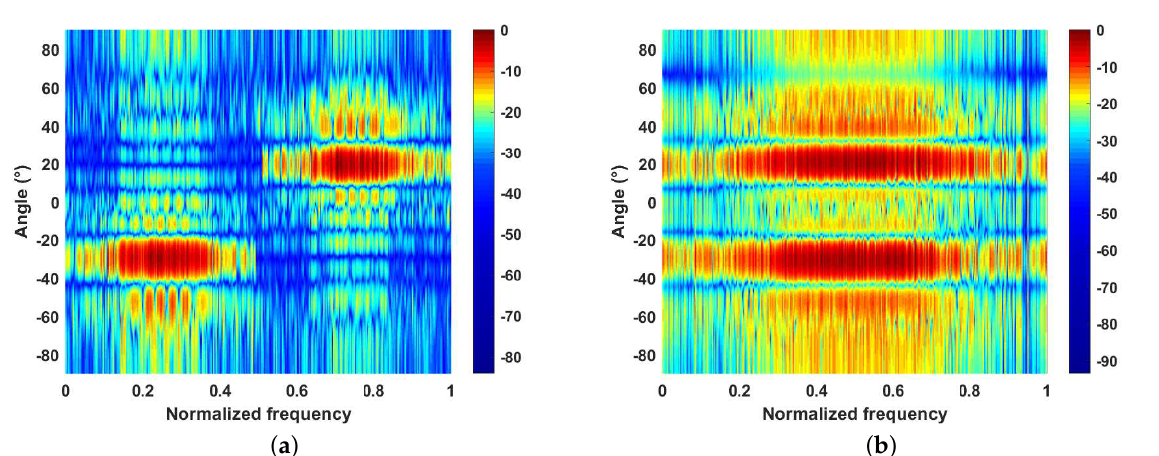
Figure 14. The power distributions in the space–frequency domain of waveforms optimized by the proposed method. ( a ) Considering the CCL. ( b ) Without considering the